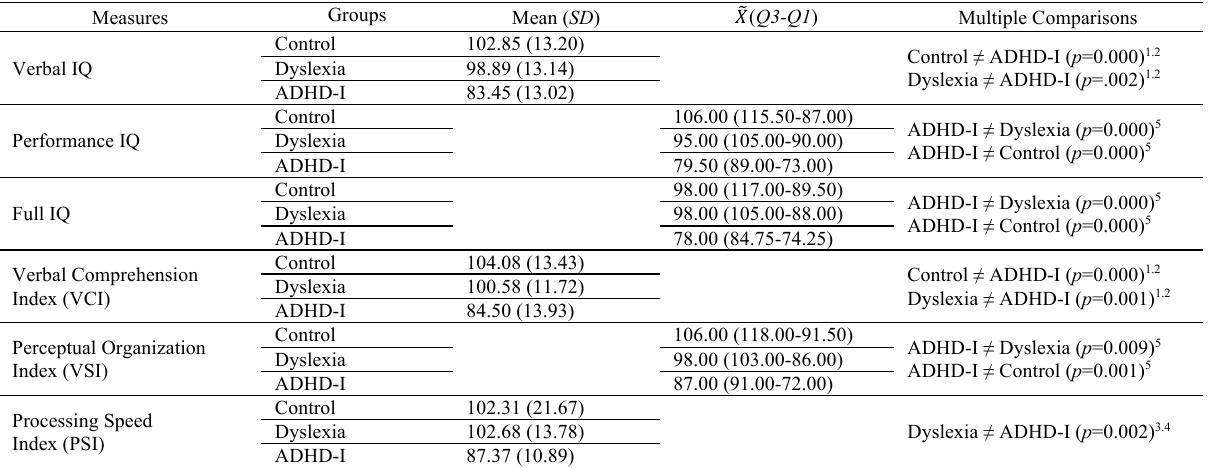
Table 10 – Means, standard deviations, median, 1 st and 3 rd percentiles, ANOVA and Kruskal-Wallis independent samples: WISC-III composite